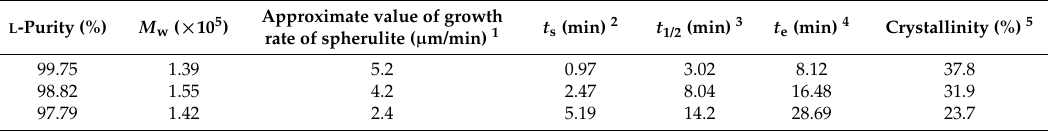
Table 2. Poly( L -lactide) (PLLA) crystallization parameters